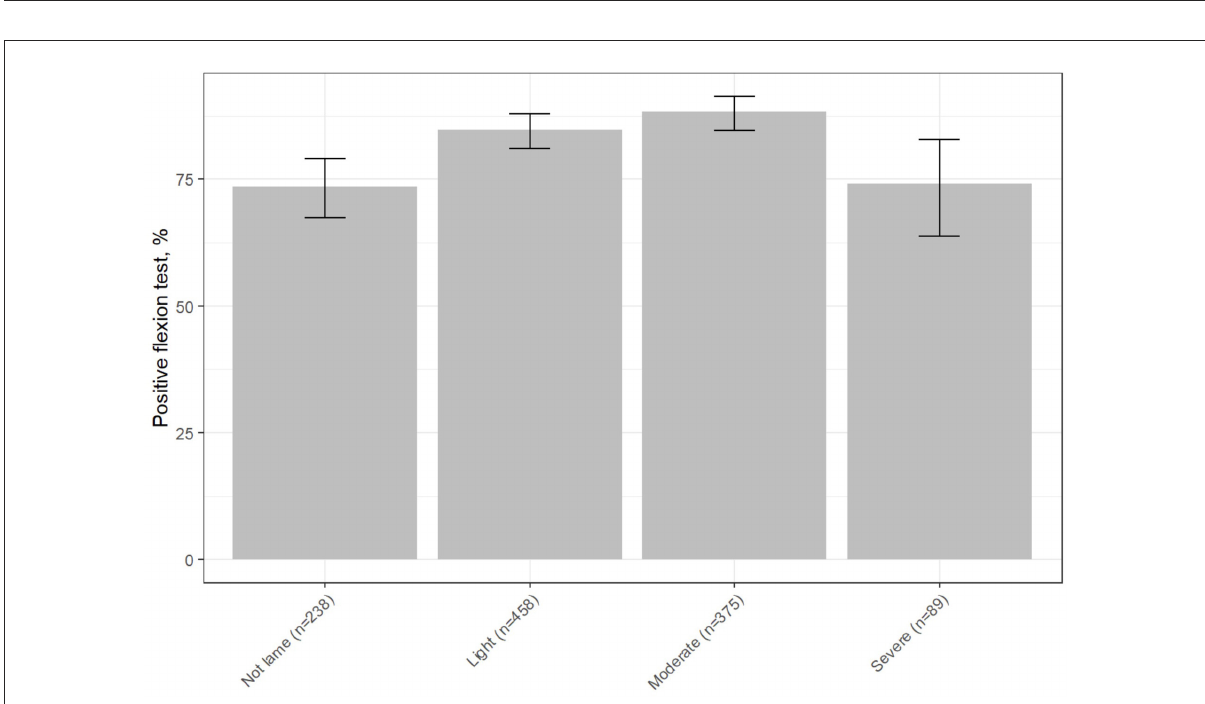
FIGURE4 Percentage of positive FT results depending on the initial lameness score result. [ x , initial lameness score (and an indication of the number of positive results); y , percentage of positive FTs]. The T bar indicates the 95%IC.